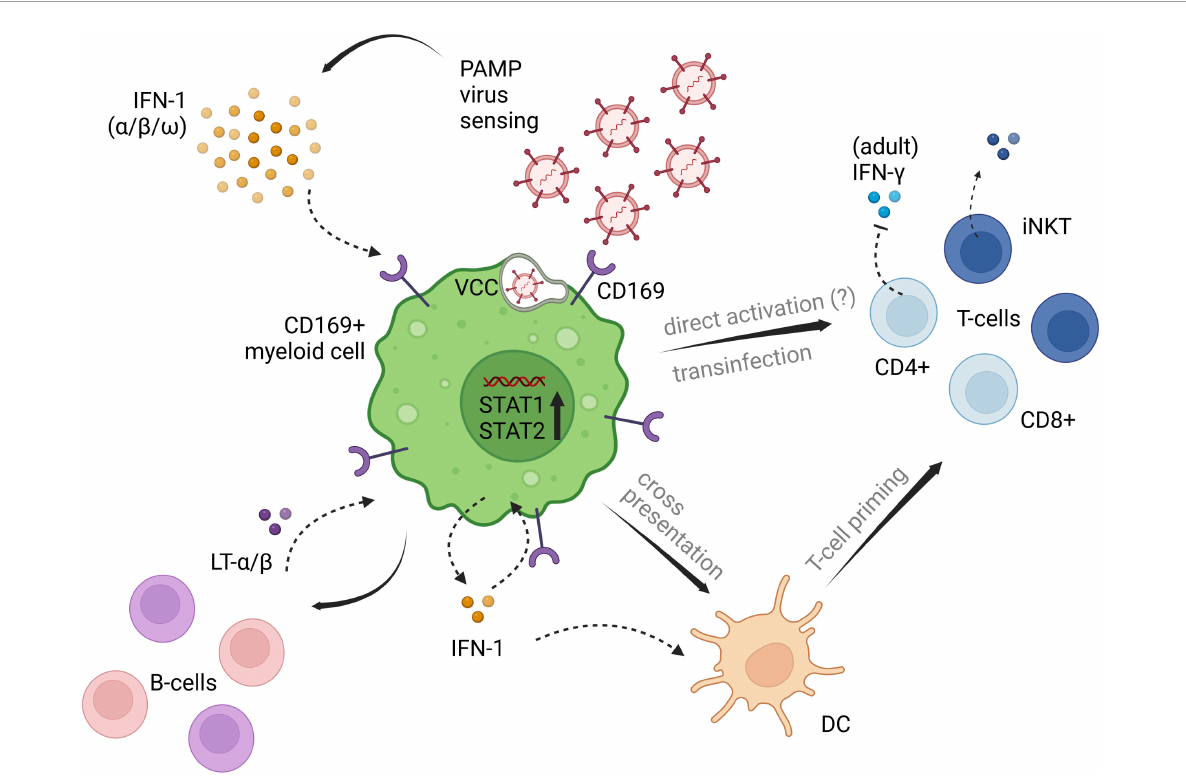
FIGURE1 Potential implications of CD169 + myeloid cells on different cell subsets of innate and adaptive immunity. CD169 + expression is induced by type I IFN signaling following viral penetration. Downstream IFN pathways are set in motion, promoting virus titer control and adaptive immune cell priming and recruitment. Influencing factors of type I IFN induced CD169, that are contributing to the impairment of antiviral immunity need further clarification. The displayed pathways likely differ between myeloid cell lines, as well as between adults and children, and are depicted in one single figure, solely for illustrating purposes of the processes described in available literature. PAMP, pathogen associated molecular patterns; LT- α / β , lymphotoxin α / β ; IFN, interferon; DC, dendritic cell; VCC, virus containing compartment. The figure was created with